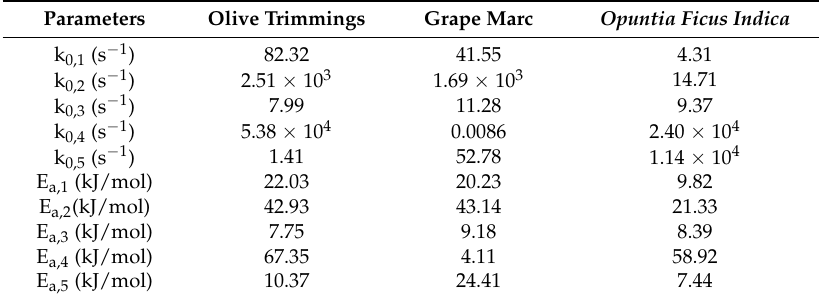
Figure 6. Arrhenius plot for determination of the activation energies (E a,i ) and pre-exponential factors (k 0,i ): ( a ) olive trimmings, ( b ) grape marc, and ( c ) Opuntia ficus indica cladodes. Table 3. Pre-exponential factors and activation energies evaluated by the Arrhenius plot for the HTC reactions for olive trimmings, grape marc, and Opuntia ficus indica.